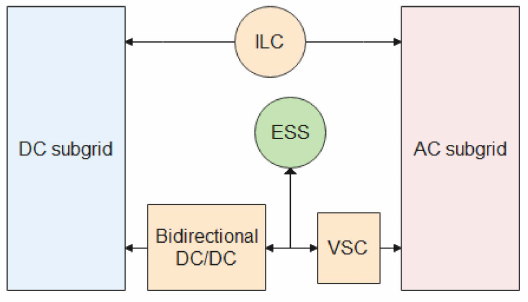
Figure 7. Modified ILC version to increase power quality